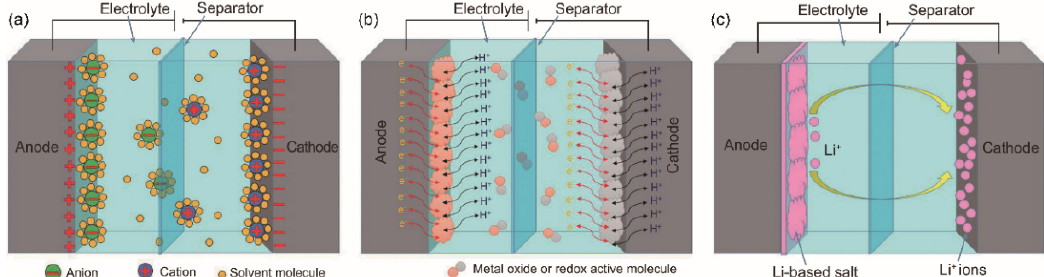
Figure 2. Energy storage principles of ( a ) electrical double-layer capacitors (EDLCs), ( b ) pseudocapacitors, and ( c ) asymmetric supercapacitors. Reprinted from ref. [32], an open-access article.